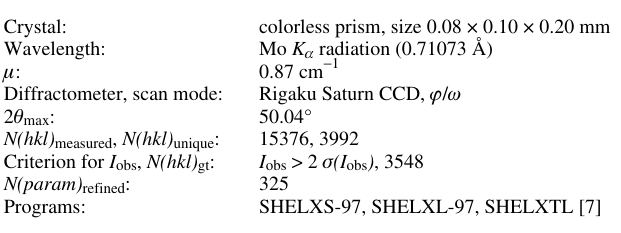
Table 1. Data collection and handling.